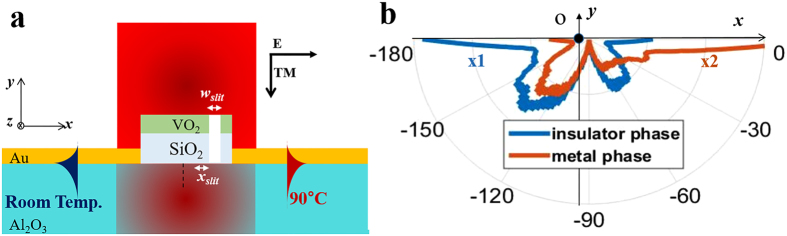
(a) A Scheme of the asymmetric VIM nanoantenna for directional switching. (b) Angular distribution of propagating power carried by backside near-fields in the both insulator and metal phases. wvo2, wslit, and xslit are set to be 750 nm, 150 nm, and 100 nm, respectively.